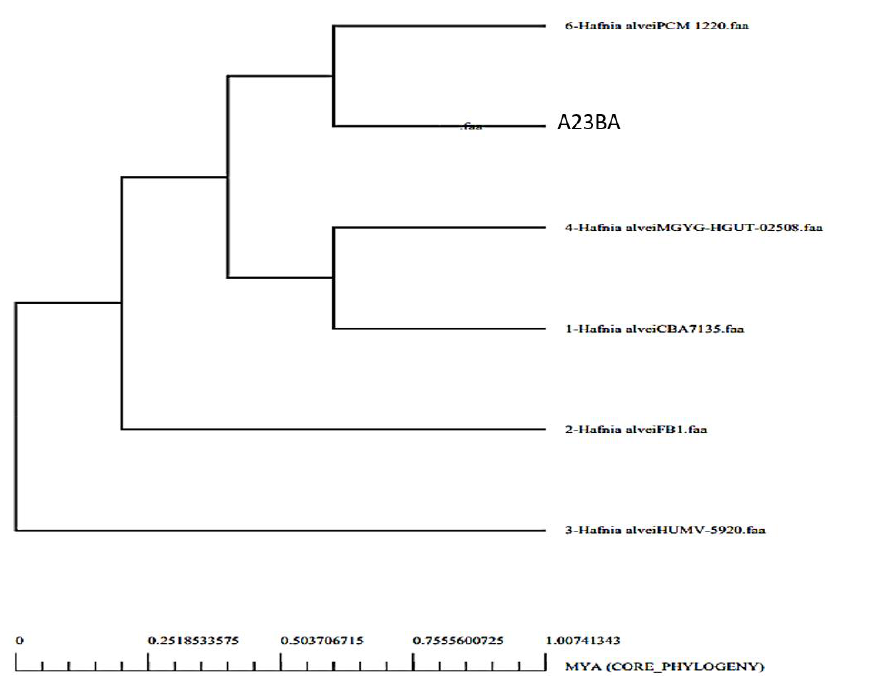
Figure 3. Phylogenetic tree of H. alvei strains.